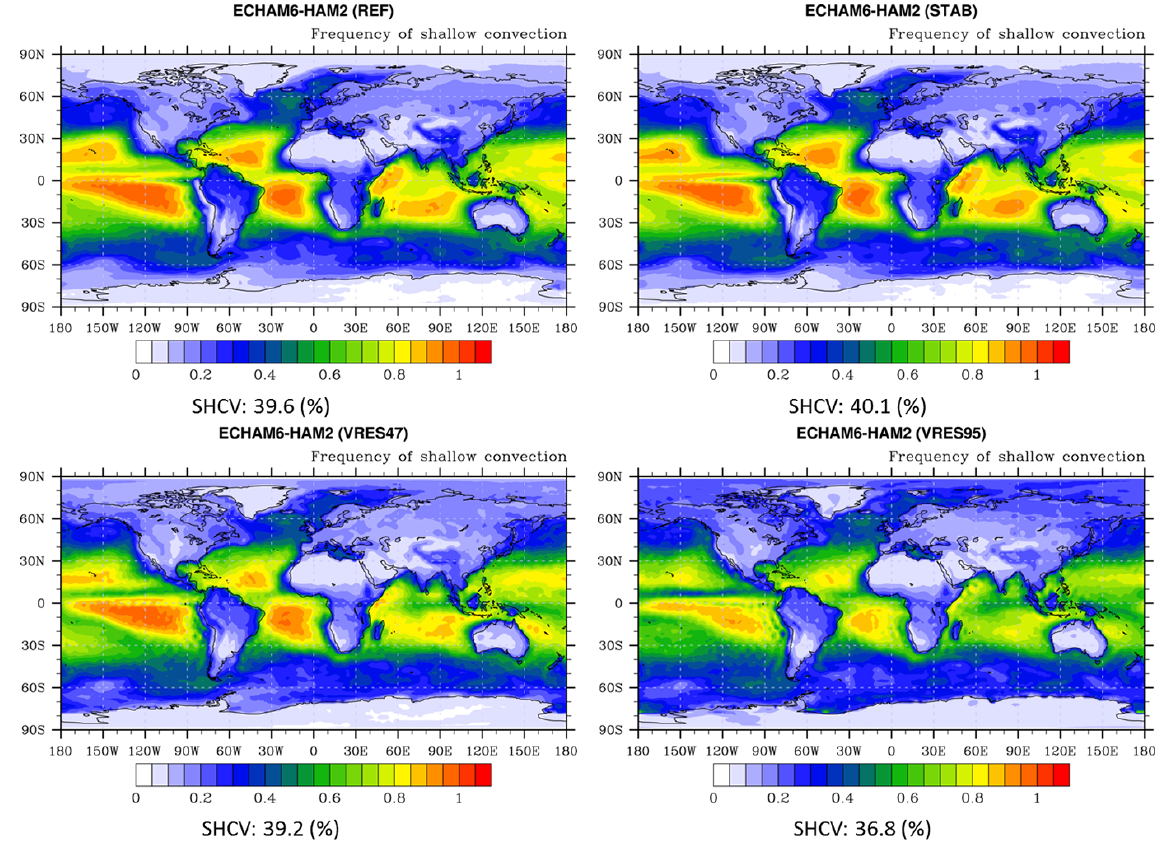
Figure C1. Frequency of the activation of the shallow-convection scheme in the REF, STAB, VRES47 and VRES95